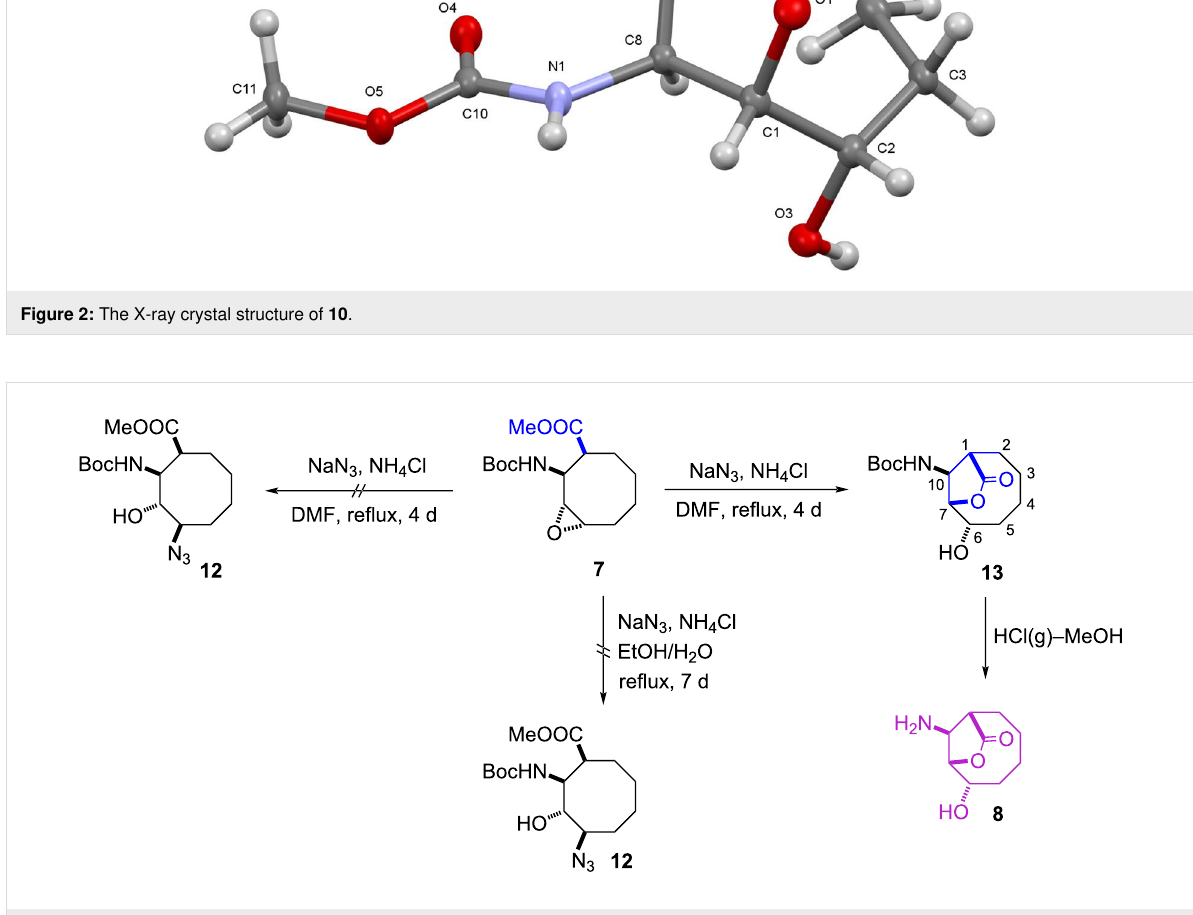
Scheme 4: Synthesis of cyclic β -amino acid derivative 8